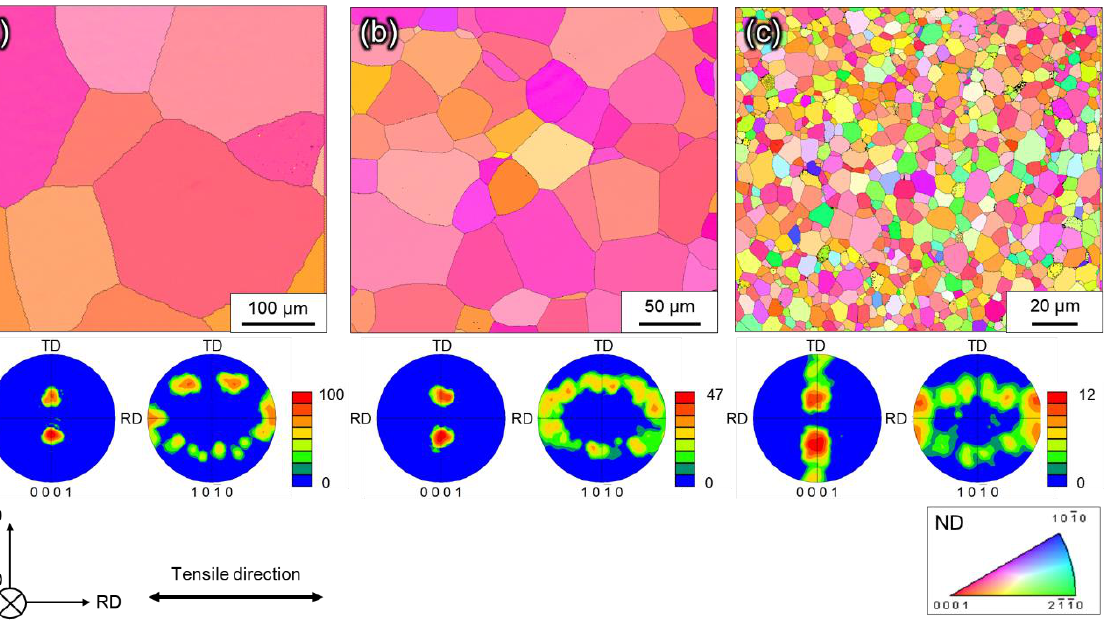
Figure 2. Crystal orientation distribution maps of initial microstructure (ND), (0001) pole figure, and {1010} pole figure of ( a ) Ti-210, ( b ) Ti-30, and ( c ) Ti-5.